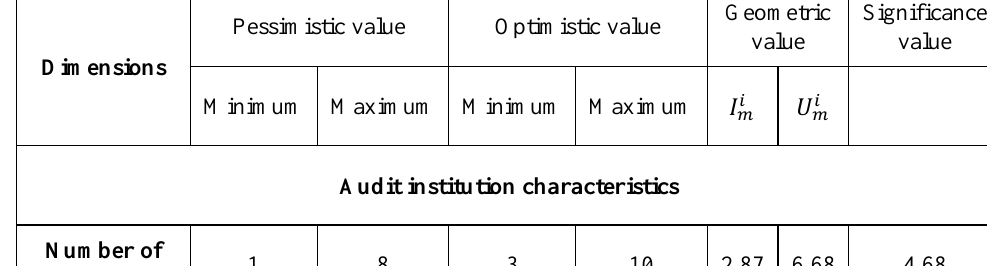
Table 6. Performance indicators based on the Fuzzy Delphi method Pessimistic value Optimistic value Dimensions